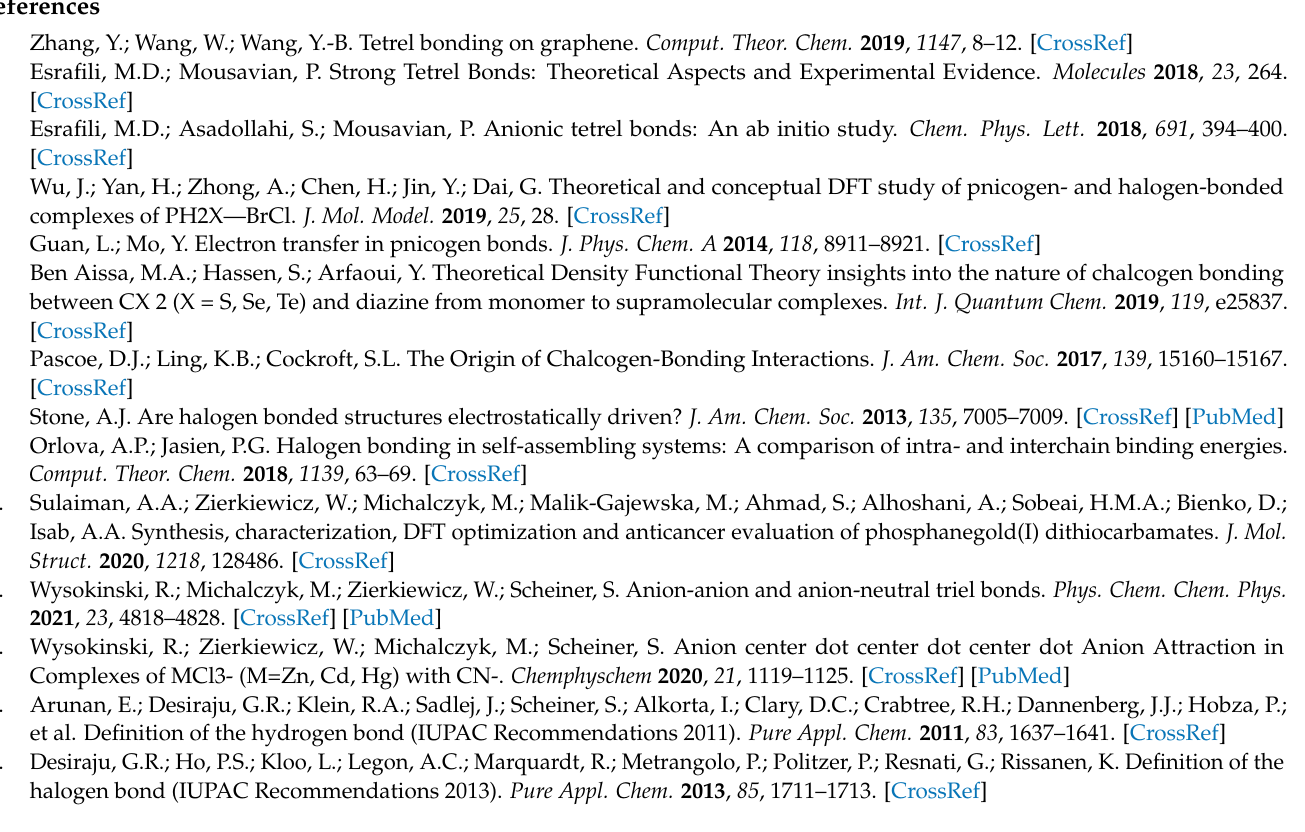
Table S6: MEP (kcal/mol of each monomer at a point along the extension of the T=Ch bond axis, at a distance from Ch that corresponds to its vdW radius in three different phases, Table S7: Atomic polar tensor (APT) charges (e) on chalcogen atom in monomers in vacuum, acetone and water solvents. Calculations performed at the MP2/aug-cc-pVDZ level of theory, Table S8: Coordinates of monomers, Table S9: Coordinates of